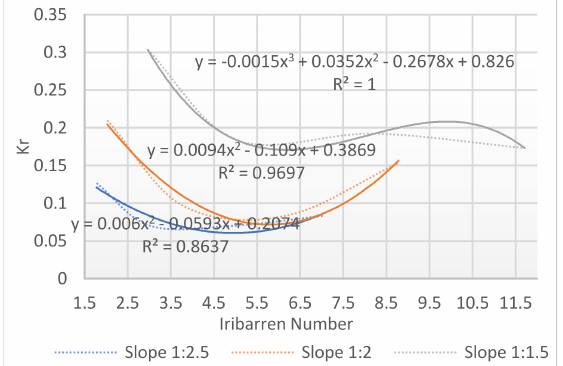
Figure 13. Iribarren number compared to Kr .